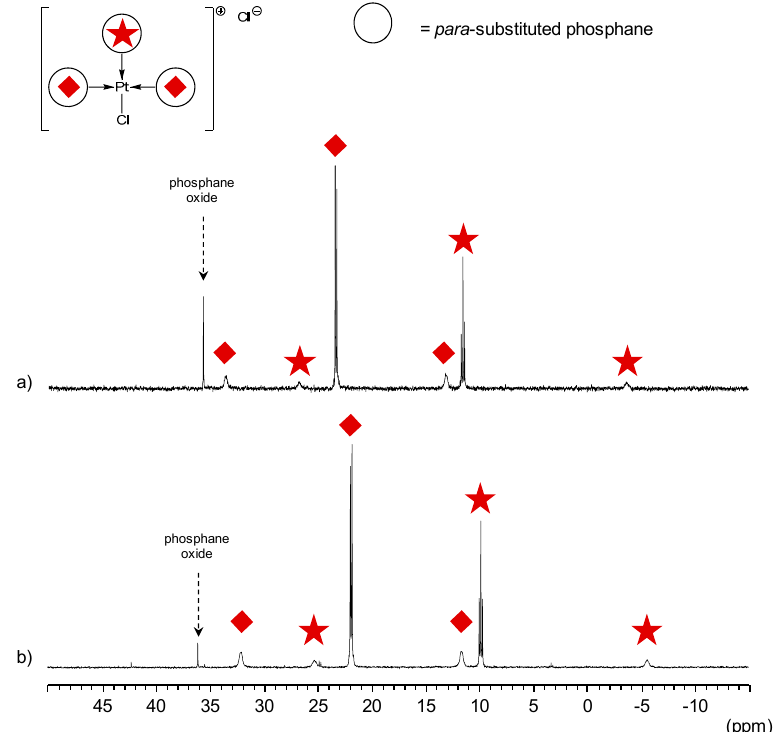
Figure 2. 31 P{ 1 H} NMR spectra of ( a ) [Pt(tris( p -Me)TPPTS) 3 Cl]Cl and ( b ) [Pt(tris( p -OMe)TPPTS) 3 Cl]Cl, [Pt] = 10 mM, 25 °C in D 2 O.